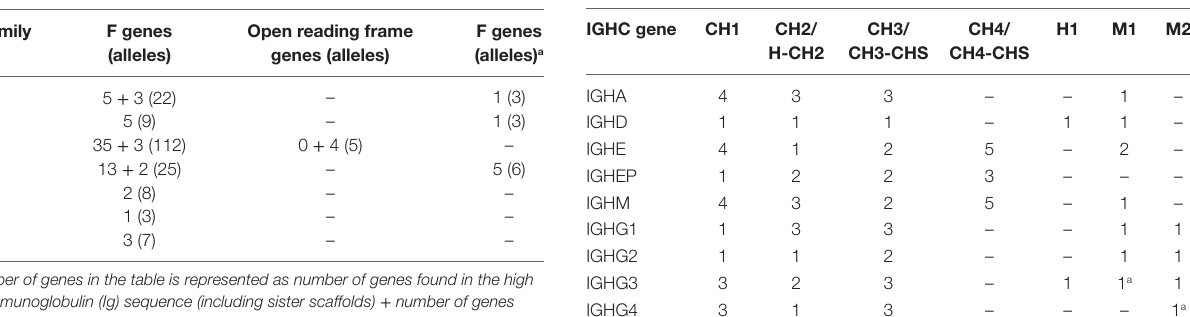
TaBle 2 | List of IGHC alleles (functional, non-functional) in the IGHC allele library.